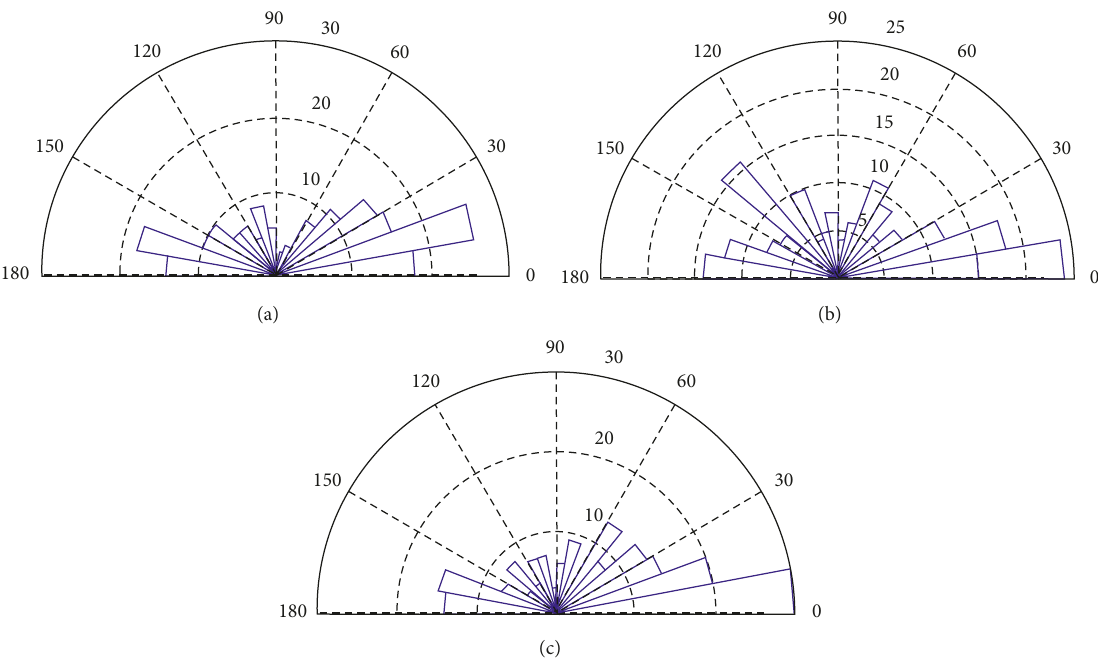
Figure 10: Rose diagrams of long axis orientation evolution. (a) ε